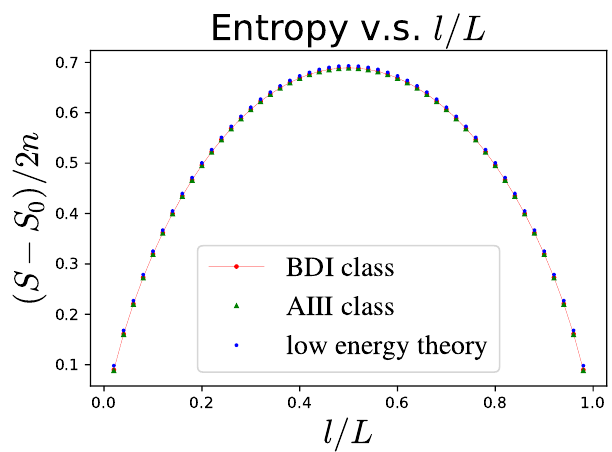
) / 2 n is plotted versus l / L . 0